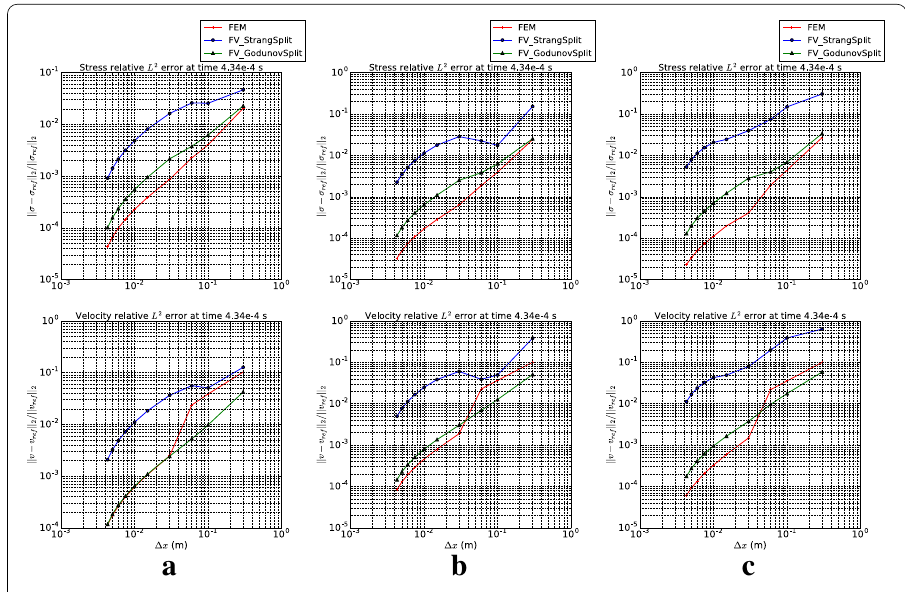
a b c Fig. 9 Relative L 2 errors of the stress and velocity computed at time 4 . 34 × 10 − 4 s with a CFL number set at one for a smooth profile of the initial velocity field. Comparison is performed for three values of the relaxation parameter τ , with the FEM, the Strang and Godunov splitting finite volume solutions. a τ = 10 − 4 s. b τ = 4 . 8 × 10 − 6 s. c τ = 10 − 7